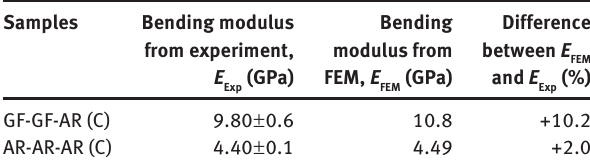
Table 9 Comparison of bending modulus between experimental and FEM in the course (C) direction.